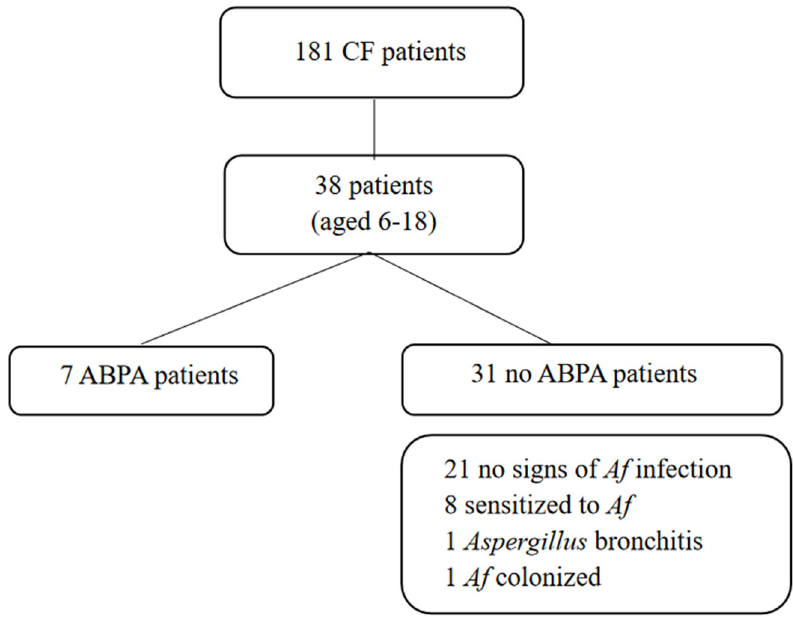
Figure 1. Study population.